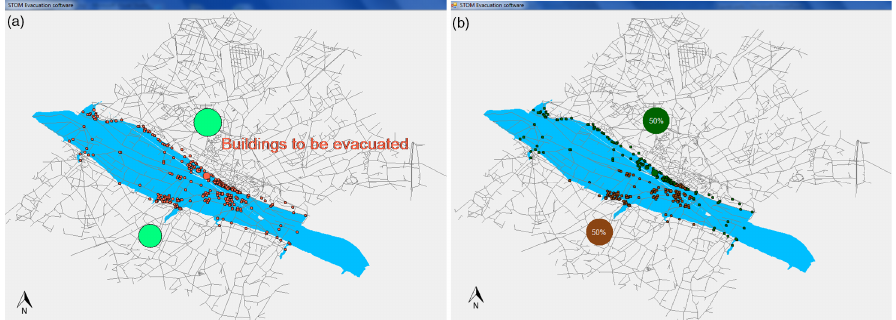
Figure 15. Construction of the evacuation plan at the beginning of the flood: (a) shows the buildings to be evacuated (in red) while (b) shows assignment of buildings to safety points.